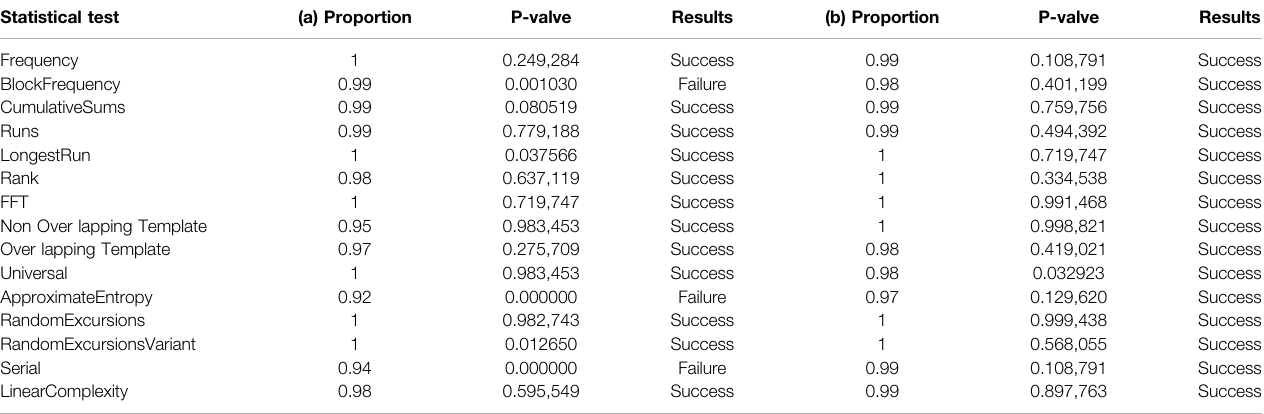
TABLE2|(A) showstherandomnesstestresultsofrandomsequencesgeneratedbyPRNGbasedontheoriginalHop fi eldneuralnetworkchaoticoscillator,and (B) shows the randomness test results of random sequences generated by PRNG with a feedback controller based on the Hop fi eld neural network chaotic oscillator. Statistical test